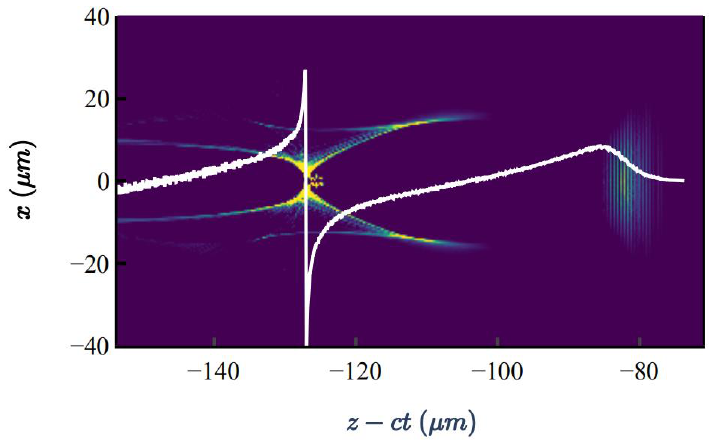
Figure 2. Snapshot of a bubble and the on-axis longitudinal field lineouts (white line) in the PIC simulation.